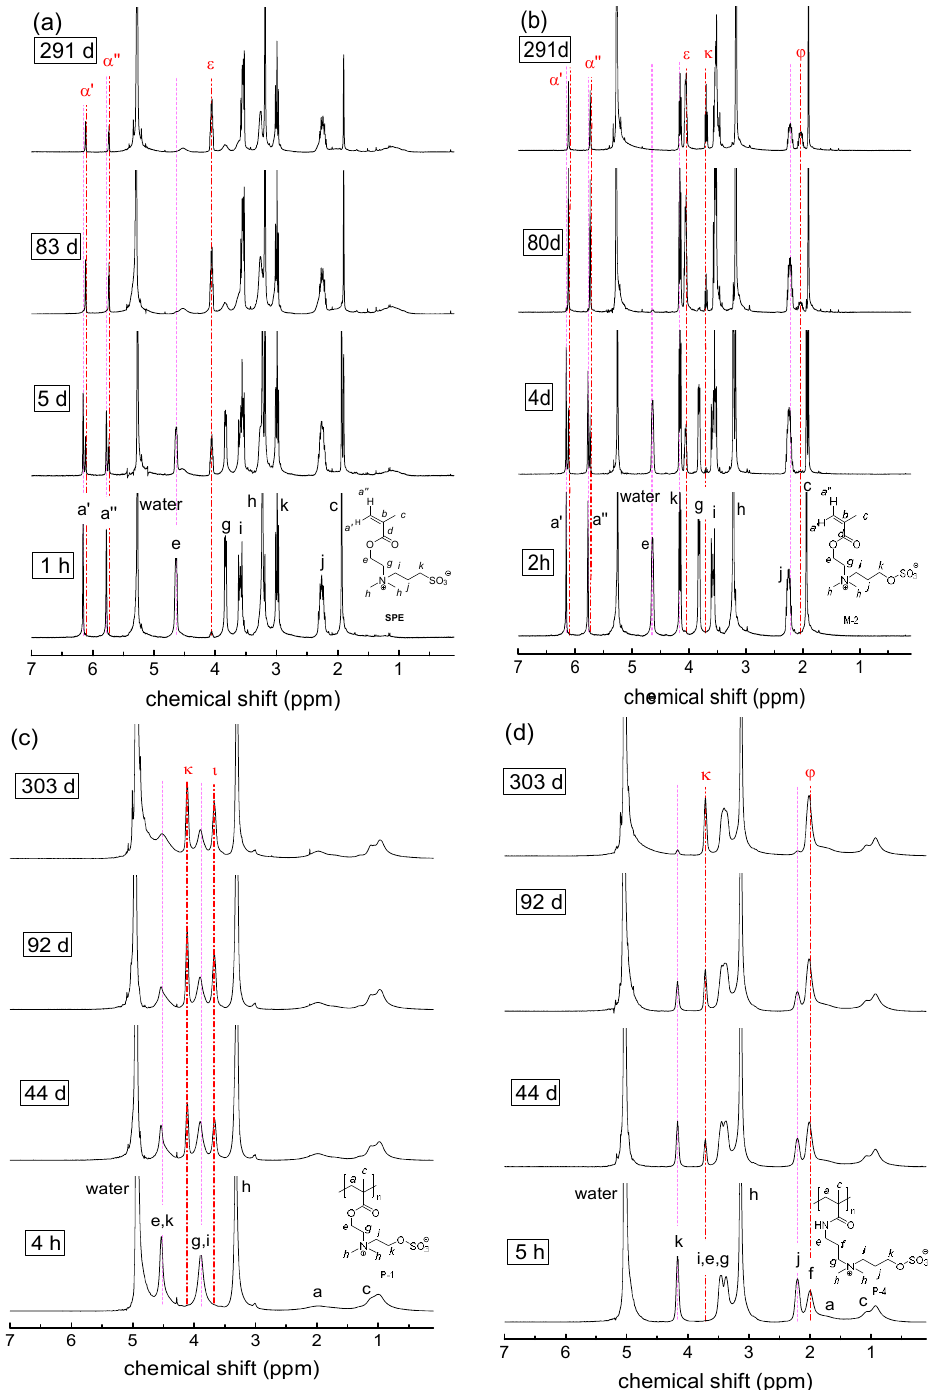
Figure 5. Evolution of the 1 H-NMR spectra over time illustrating the degradation behavior in 1 M hydrochloric acid (DCl in D 2 O, pH = 0) at room temperature for: ( a ) SPE ; ( b ) M-2 , ( c ) P-1 ; ( d ) P-4 . Signal attributions of the starting compounds are labeled by roman letters, signal attributions of the degradation product by corresponding Greek letters ( cf. Figure 4). Broken vertical lines are meant as guide to the eye.